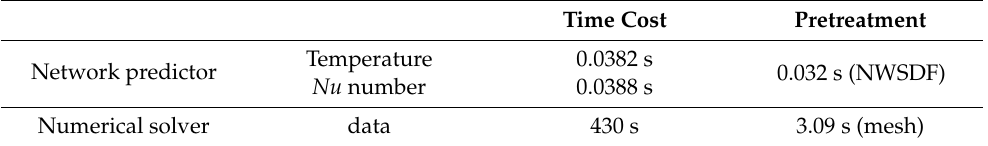
Table 2. Time usage of network model prediction and numerical solver